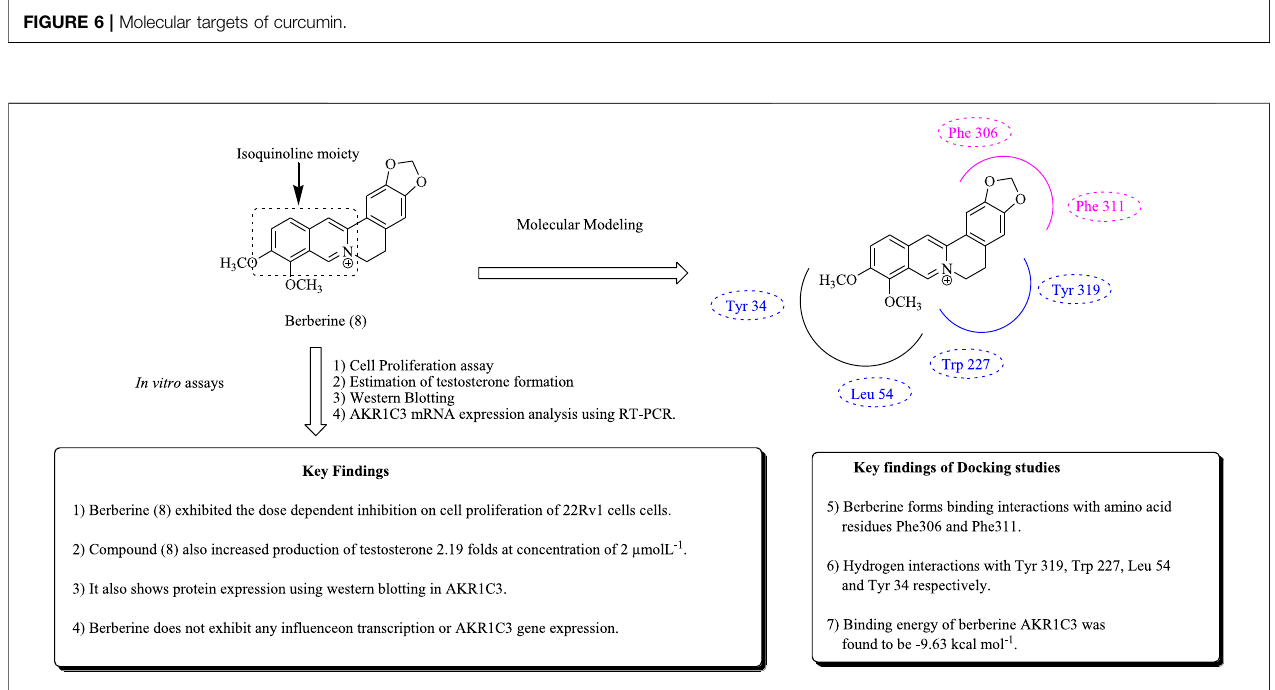
FIGURE 7 | Structure of berberine along with important key fi ndings.